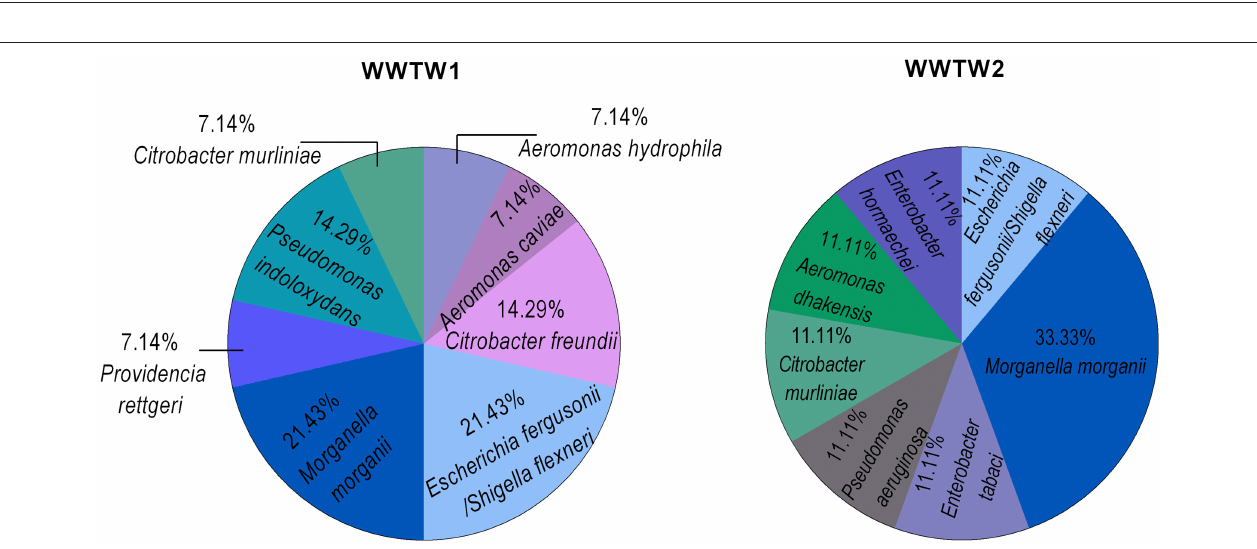
FIGURE 5 | Species composition from different WWTW effluent samples previously exposed to antibiotics (WWTW1: n = 12; WWTW2: n = 7), and not previously exposed to antibiotics (WWTW1: n = 2; WWTW2: n =